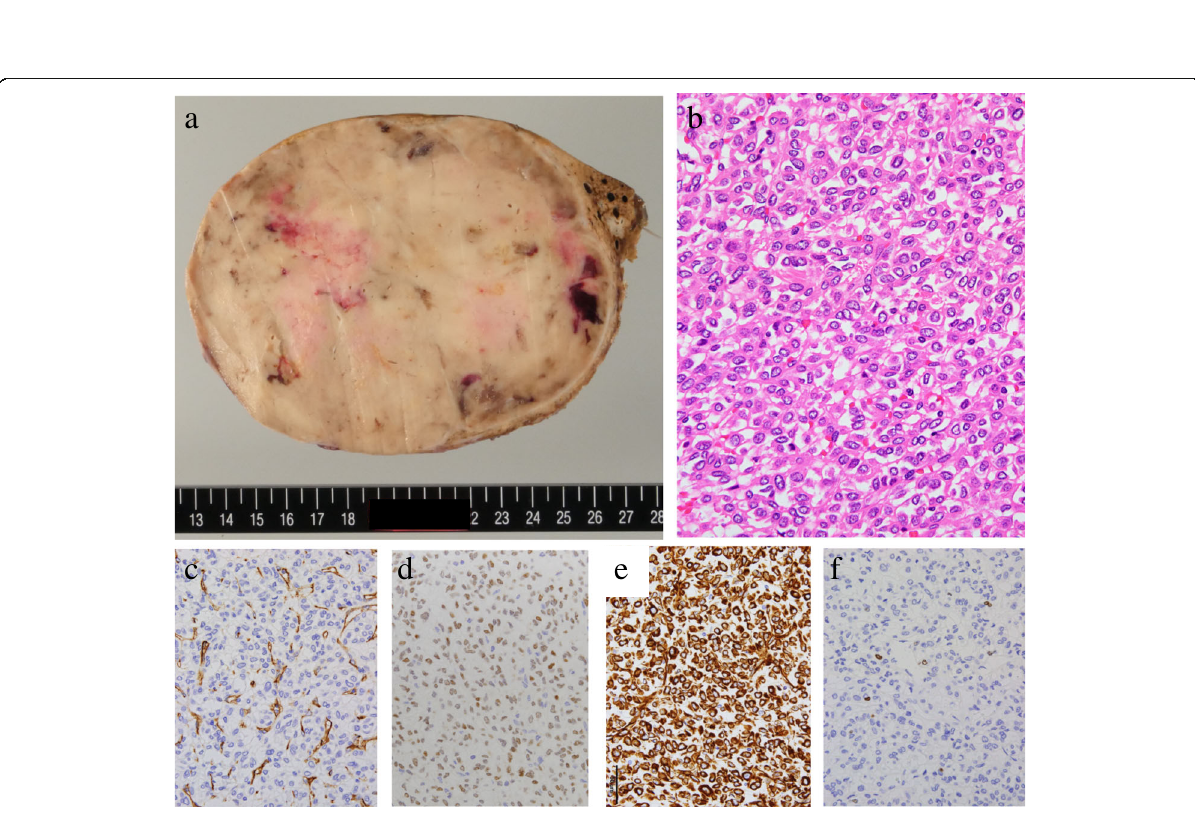
Fig. 3 Macroscopic and microscopic findings of SFT. Macroscopically, the tumor mass was firm and yellowish-white with an intact capsule (13.3 cm maximum diameter) ( a ). Microscopically, the tumorous tissue showed a proliferation of oval to short spindle-shaped cells arranged in a “ pattern-less pattern ” (H&E × 400) ( b ). Immunohistochemically, the tumor cells were negative for CD34 (× 400; c ), but positive for STAT6 (nuclei, × 400) ( d ) and vimentin (× 400) ( e ). Ki67 labeling index was < 5% (× 400) ( f